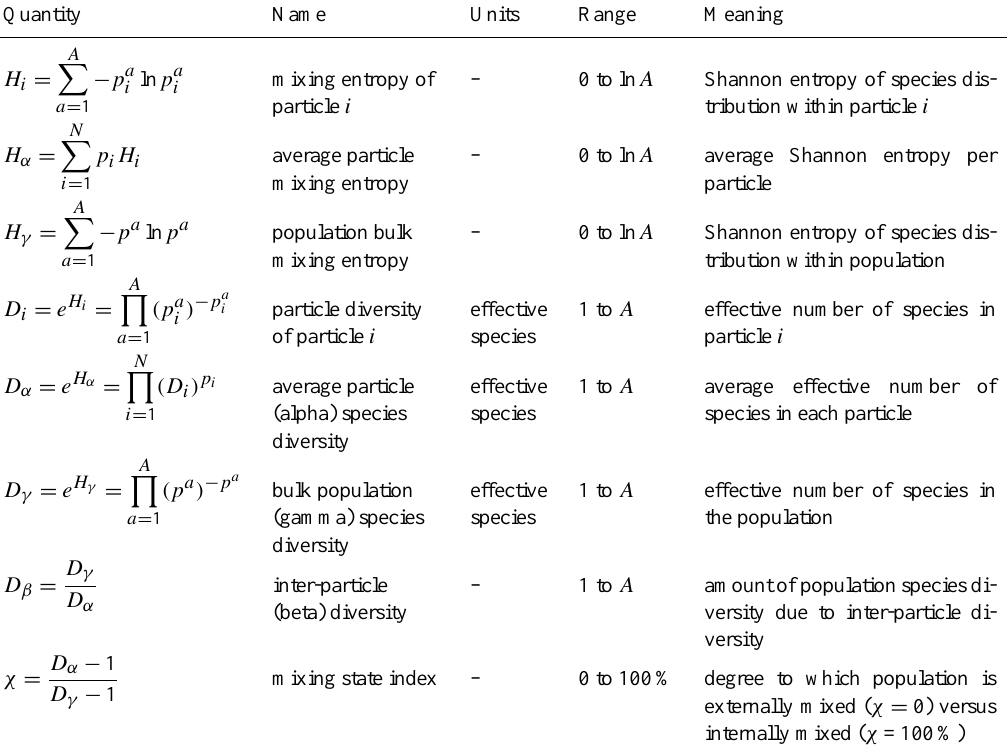
Table 2. Definitions of aerosol mixing entropies, particle diversities, and mixing state index. In these definitions we take 0ln0 = 0 and 0 0 = 1.